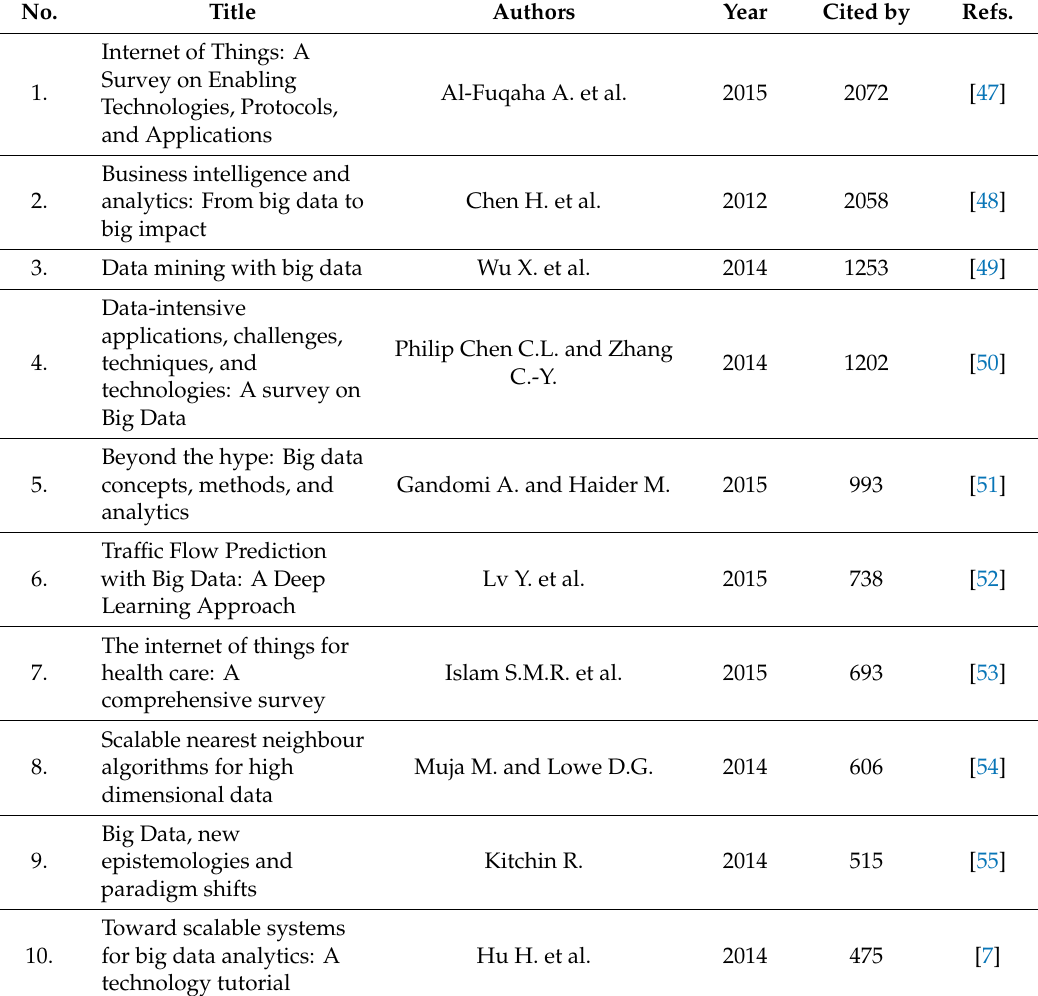
Table 5. Top 10 highly cited